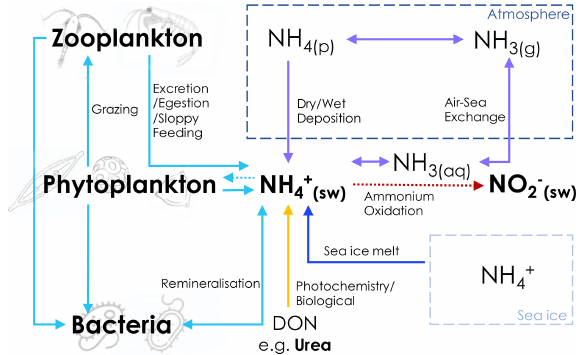
Figure 9. Schematic of the possible mixed-layer NH + assimila- 4 tion and production pathways. Bold text indicates components of the NH + cycle that were directly measured in this study (seawater 4 concentrations of NH + , NO − , and urea; phytoplankton, bacterial, 4 2 and microzooplankton cell abundances), and dotted lines indicate processes for which we have direct rate measurements (phytoplank- ) . Dashed-line boxes ton uptake of NH + , oxidation of NH + to NO − 4 4 2 represent the atmosphere and sea ice, with all other processes oc- curring in the ocean. DON – dissolved organic nitrogen; NH 3 ( aq ) – aqueous (seawater) ammonia; NH 4 ( p ) – ammonium aerosols (in- cluding ammonium sulfate, ammonium bisulfate, and ammonium nitrate); NH 3 ( g ) – ammonia